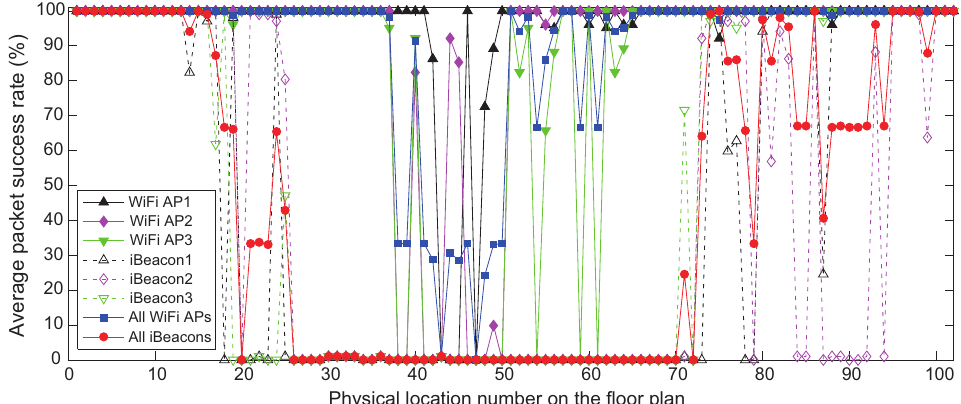
Figure 8. Average value of packet success rate measured by the mobile phone of 50 users at each physical location on the floor plan in the hallway Scenario